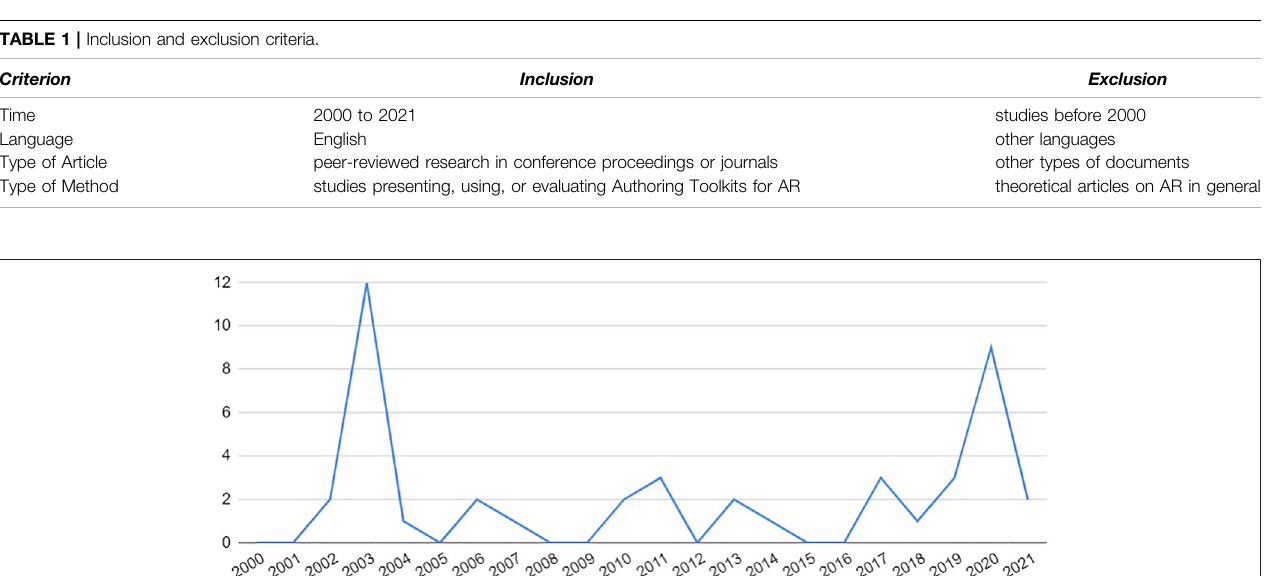
FIGURE 2 | Publication years of the selected articles.